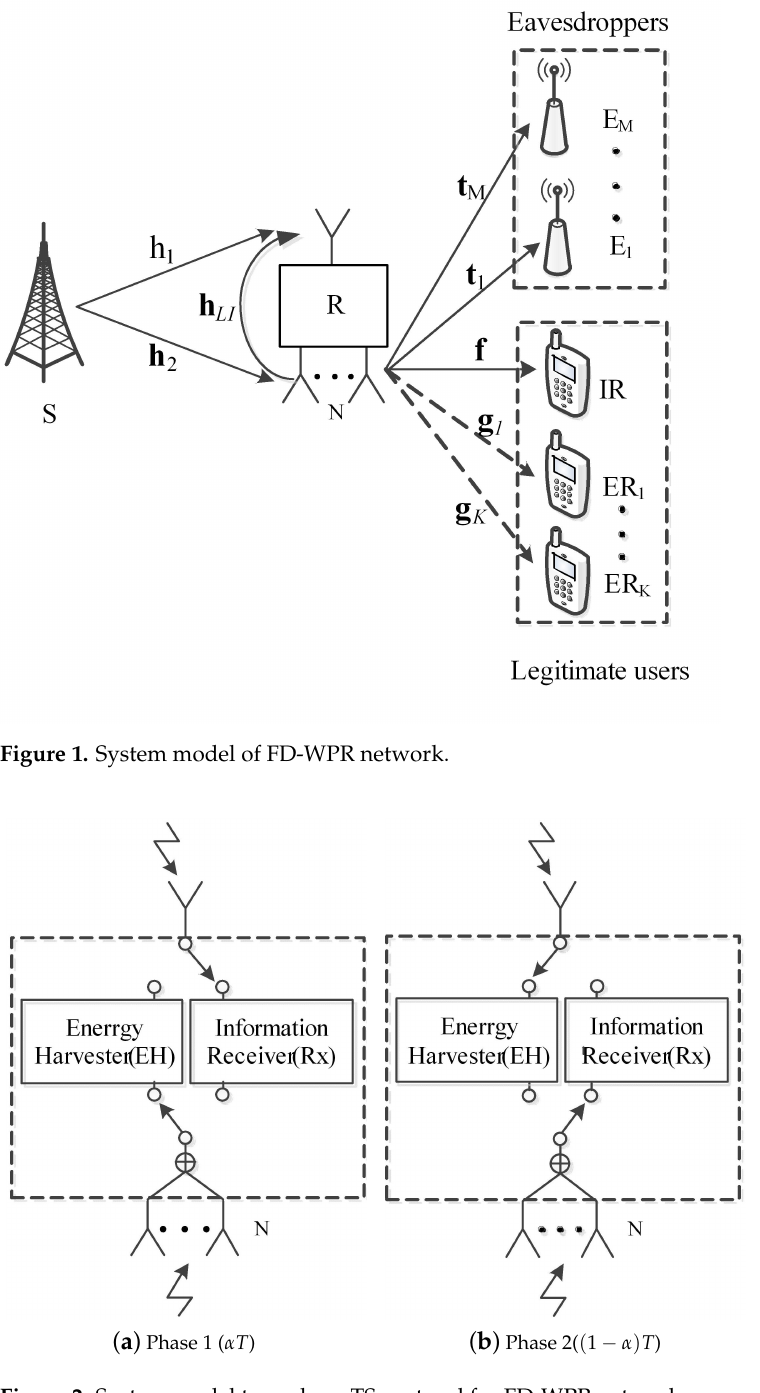
Figure 2. System model two-phase TS protocol for FD-WPR